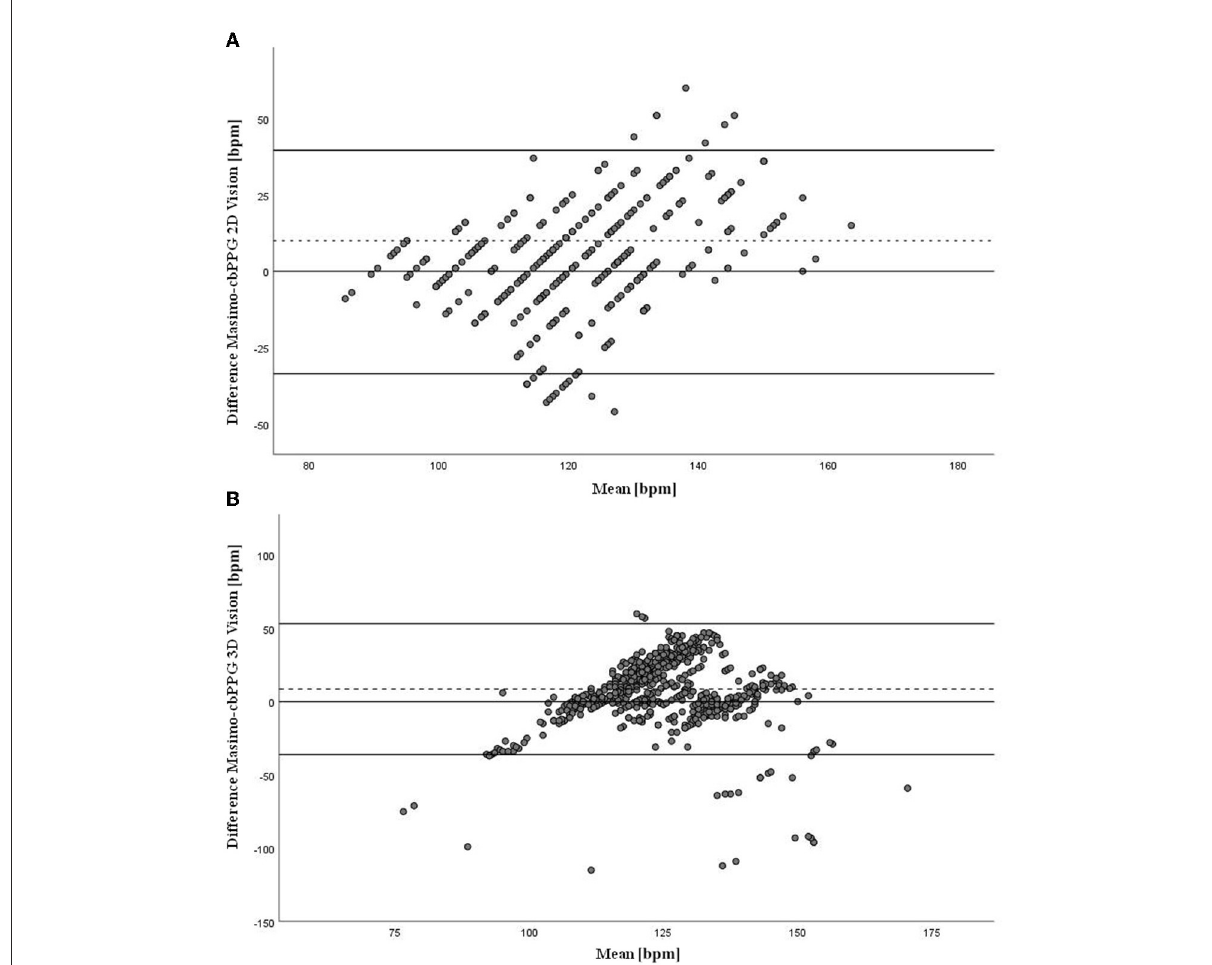
FIGURE5 (A) Bland-Altman plot shows the level of agreements between the measured HR of Masimo-sensor and the camera-based sensor. The y-axis shows the difference between the two methods (bpm), x-axis shows the mean of the two methods (bpm) (2D vision). (B) Bland-Altman plot shows the level of agreements between the measured HR of Masimo-sensor and the camera-based sensor. The y-axis shows the difference between the two methods (bpm), x-axis shows the mean of the two methods (bpm) (3D